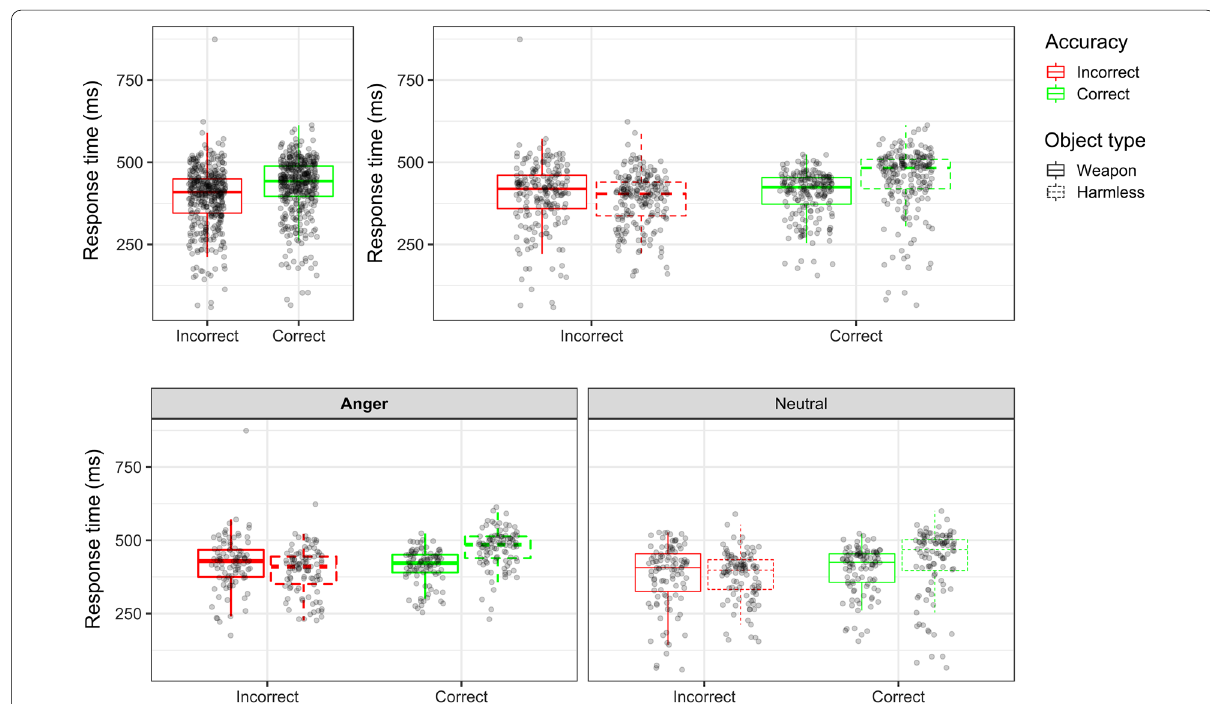
Fig. 3 Boxplots detailing raw RTs as a function of response correctness, averaged across both emotion condition and object type (top left), separately by object type (top right), and separately by emotion condition and object type